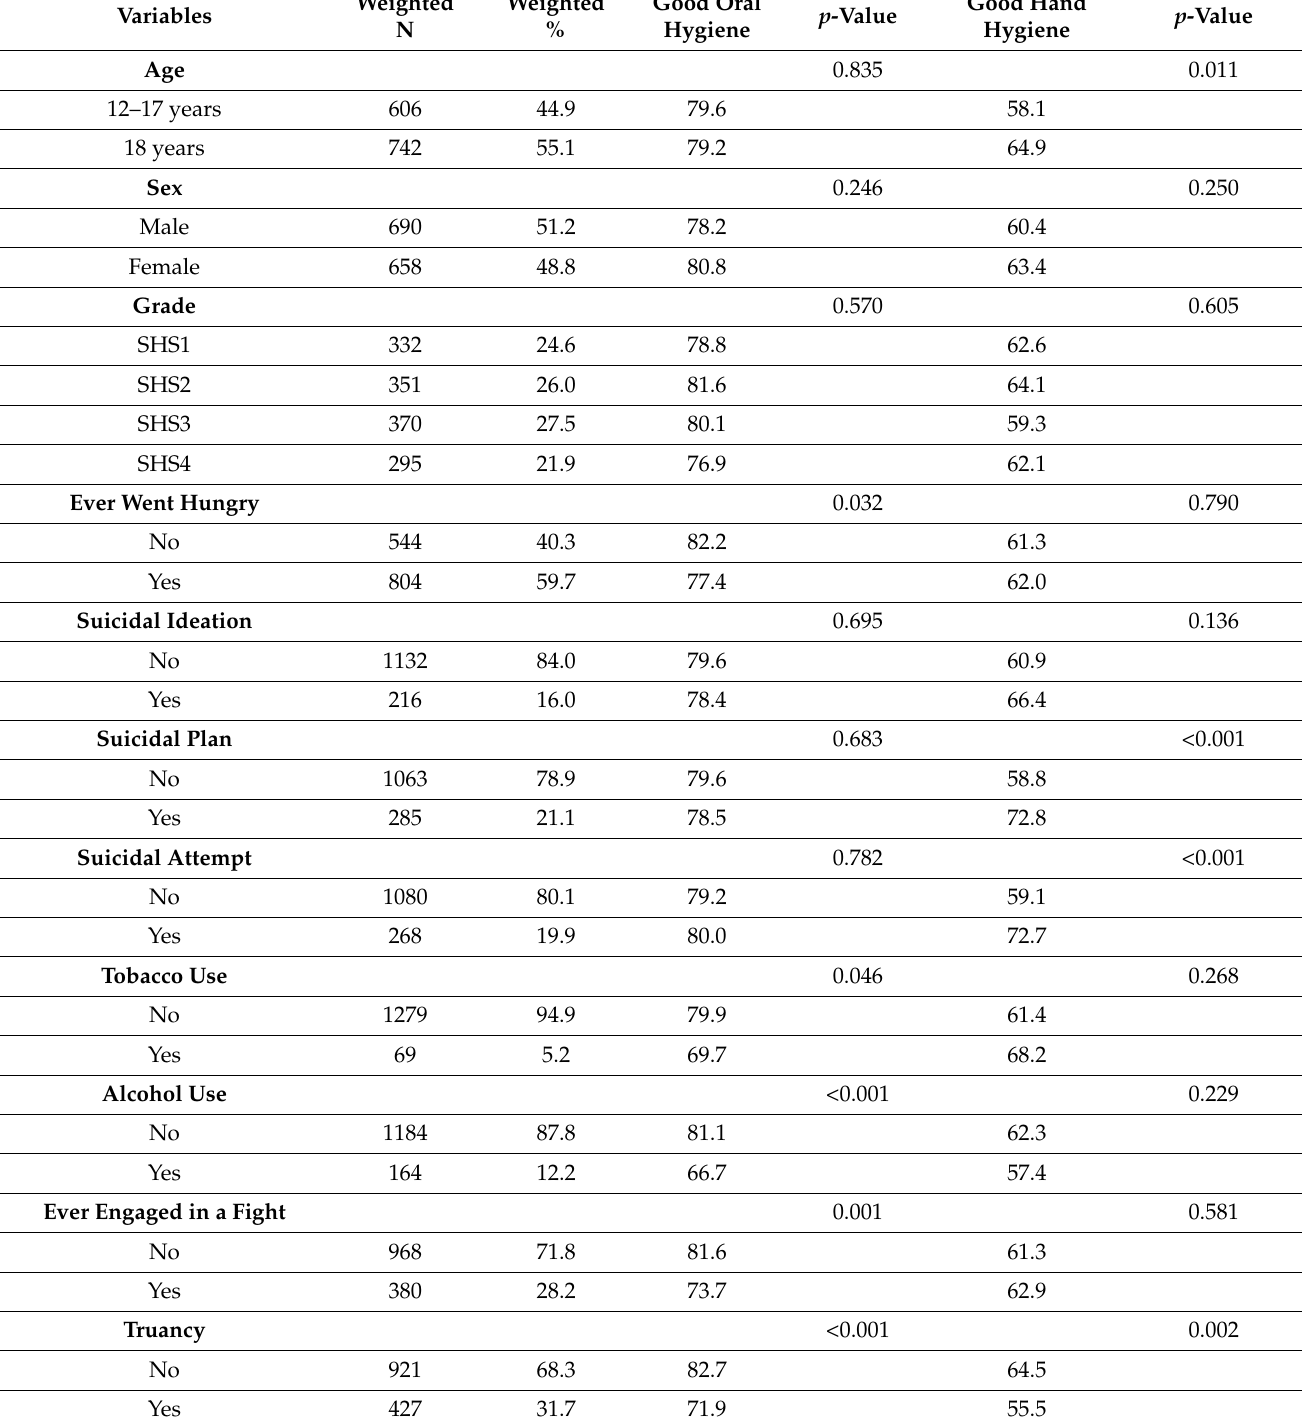
Table 2. Bivariable Relationship between Hygiene Behaviours and the Explanatory